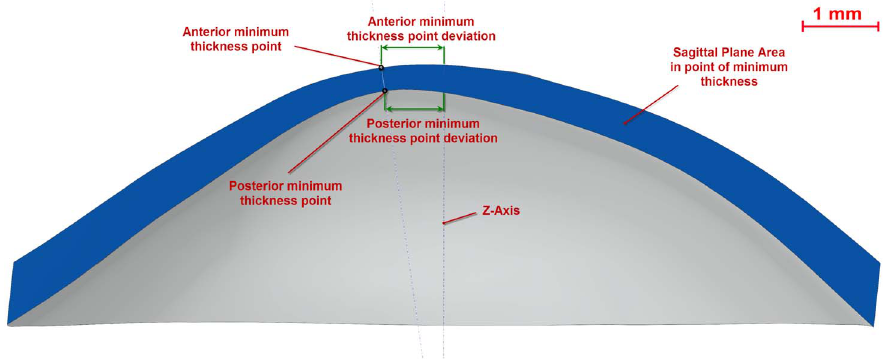
Figure 4. Sagittal plane of the cornea passing through the Z axis and minimum thickness points of both corneal surfaces.